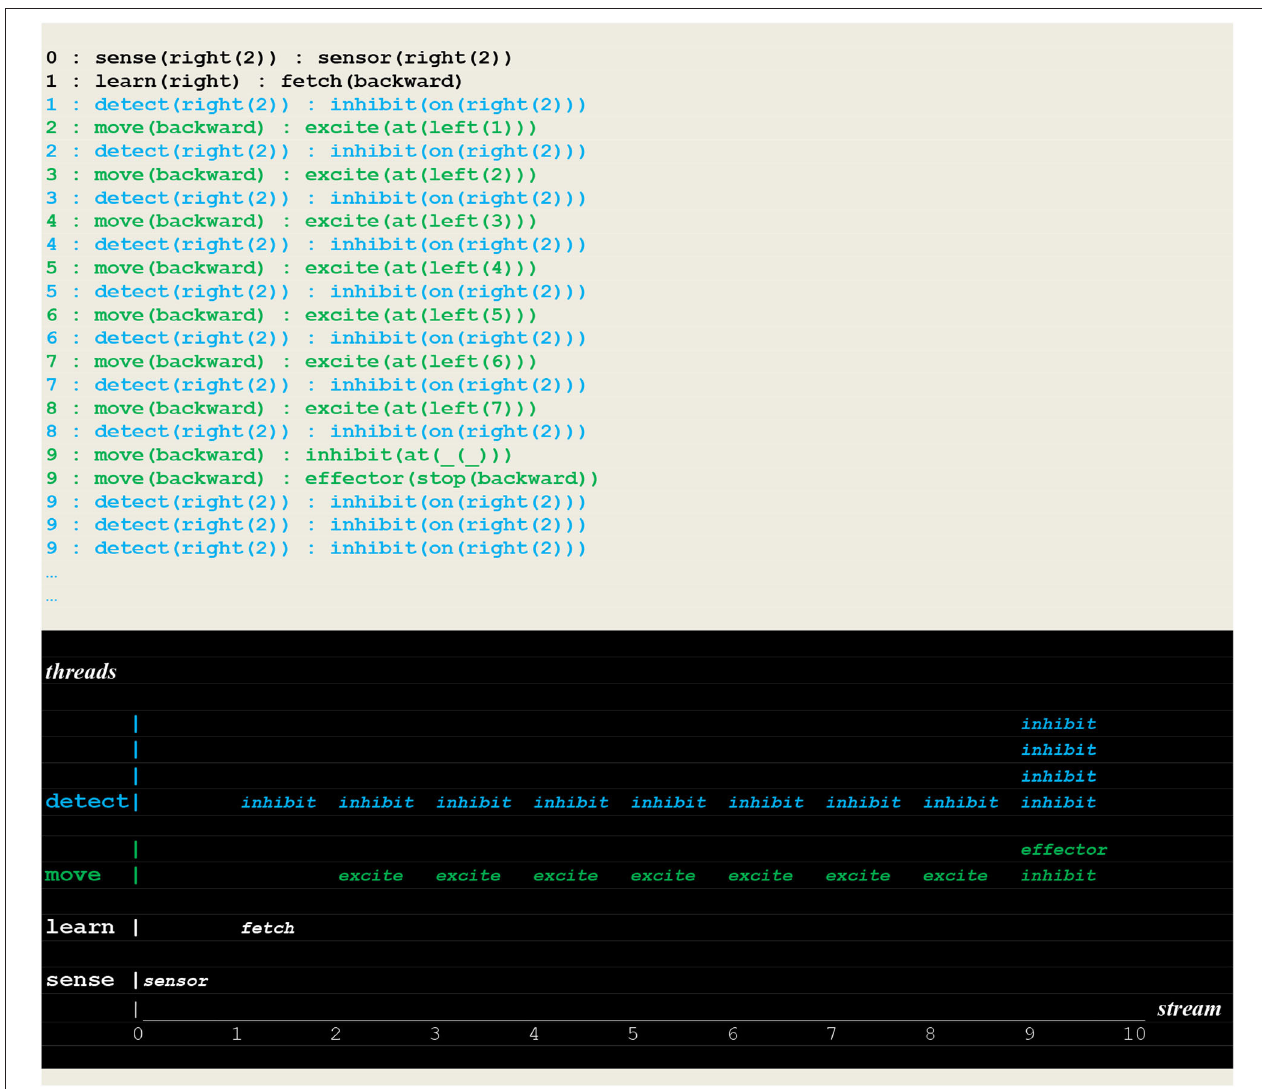
FIGURE 16 | Execution trace of failing to detect a new fire: Facing an open path to learn , the vehicle made a random choice learn(right):fetch(backward) i.e., an incorrect choice that did not lead him to detect the